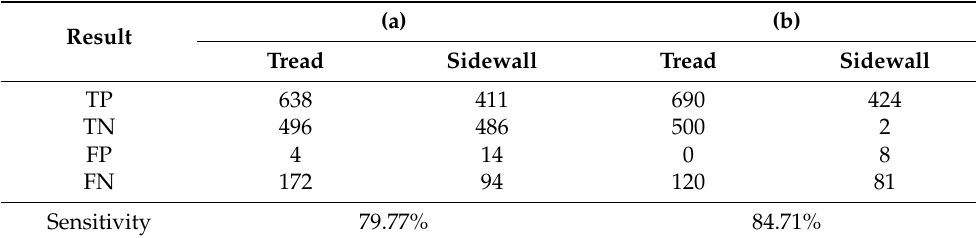
Table 3. Results Obtained by (a) the Tiny YOLO Architecture, (b) the incremental Tiny YOLO Architecture.